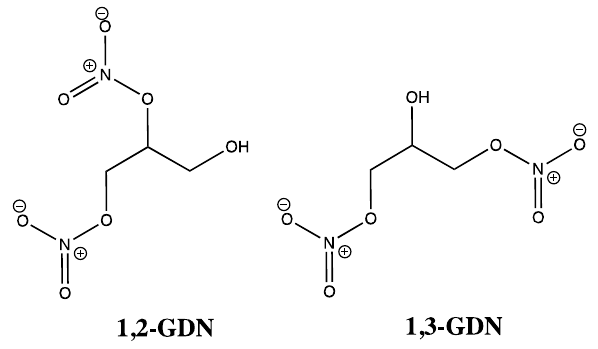
Figure 2. Chemical structures of 1,2-GDN and 1,3-GDN.